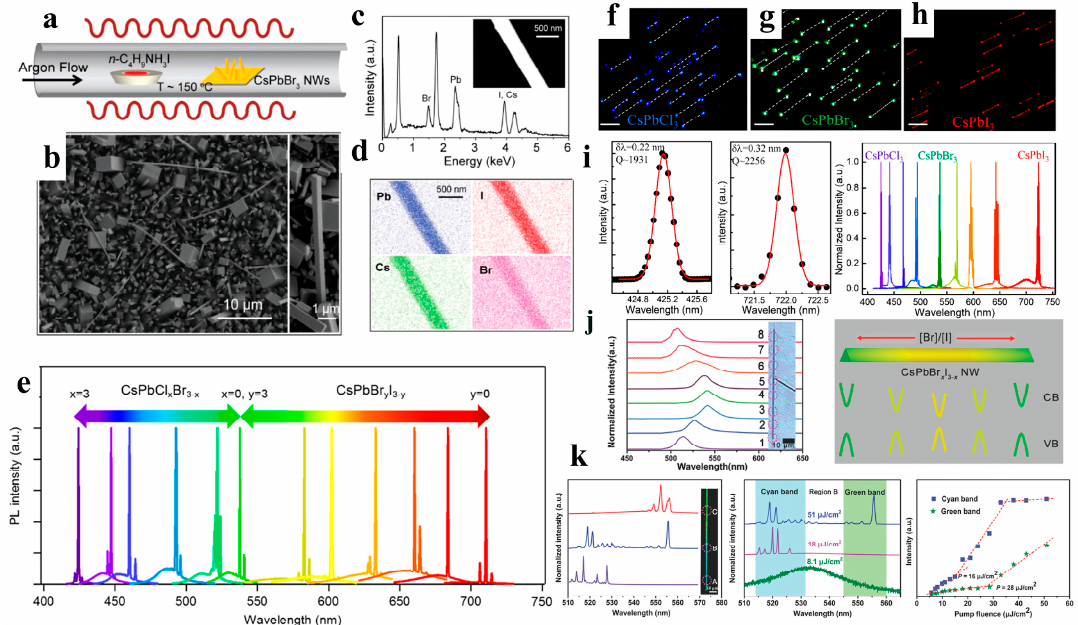
Figure 11. ( a ) Schematic illustration of the vapor conversion of CsPbBr 3 into CsPb(Br,I) 3 by intro ‐ ducing n ‐ butylammonium iodide at approximately 150 °C. ( b ) SEM image of the obtained CsPb(Br,I) 3 , reacted for 2 min. The right inset shows a single NW with a rectangular flat end ‐ facet. ( c ) EDX measurement result of an individual NW (inset). ( d ) EDX mapping of the corresponding NW. ( e ) Tunable lasing characteristic of CsPbX 3 single ‐ crystal NWs. Reproduced with permission from reference [17]. Copyright 2016, American Chemical Society. ( f – h ) Optical images of CsPbCl 3 , CsPbBr 3 , and CsPbI 3 NW in the in ‐ plane direction (scale bar: 10 μ m). ( i ) Gaussian fitting of the lasing spectra detected from CsPbCl 3 (left) and CsPbI 3 (middle) NWs. The broad wavelength tunable lasing spectra of CsPbX 3 and alloy NWs (right). Reproduced with permission from reference [100]. Copy ‐ right 2016, American Chemical Society. ( j ) Normalized μ‐ PL spectra (left) and bandgap schematic diagram (right) of the composition ‐ graded CsPbBr x I 3 − x NW. ( k ) μ‐ PL spectra of the CsPbBr x I 3 − x NW at different positions measured above the threshold. Reproduced with permission from reference [101]. Copyright 2016, American Chemical Society.